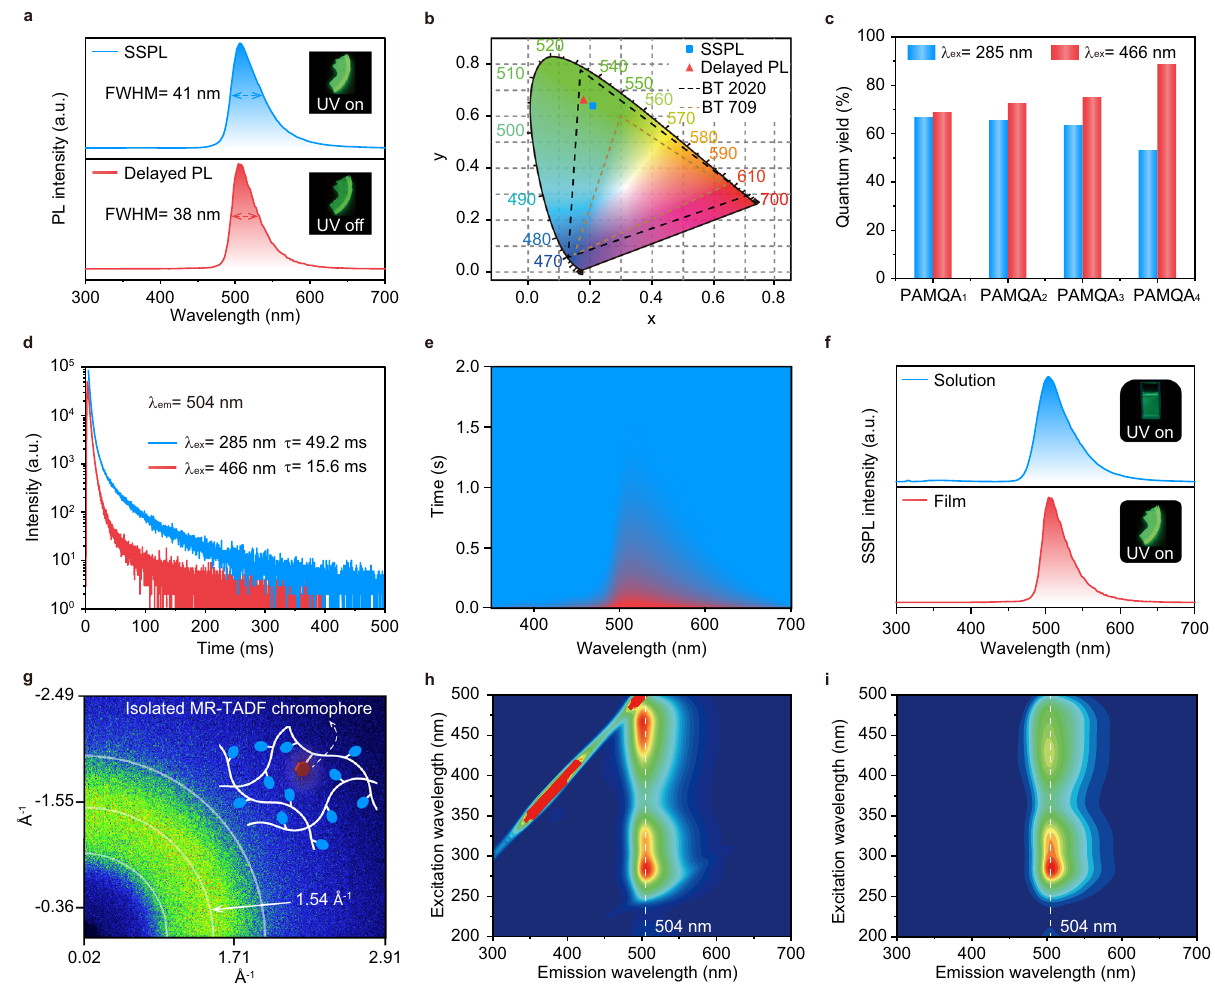
Fig. 2 | Photophysical properties of hyperafterglow polymers under ambient conditions. a Normalized steady-state PL (SSPL, blue line) and delayed PL (10ms delay) spectra (red line) of PAMQA 3 fi lm ( λ ex =285nm). Inset: photographs of PAMQA 3 fi lmtakenuponturningon(toppanel)andoff(bottompanel)a285nmUV lamp. b CIE chromaticity diagram for SSPL and delayed PL emission of PAMQA 3 ( λ ex =285nm). c PLQYs of PAMQA x fi lms upon 285 and 466nm excitation. d Lifetimedecaypro fi lesofemissionbandat504nmofPAMQA 3 fi lmupon285and